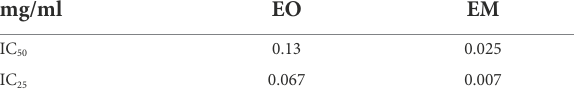
TABLE 4 Inhibitory concentration values of cinnamon essential oil and its emulsion tested on MRC-5 cell line.